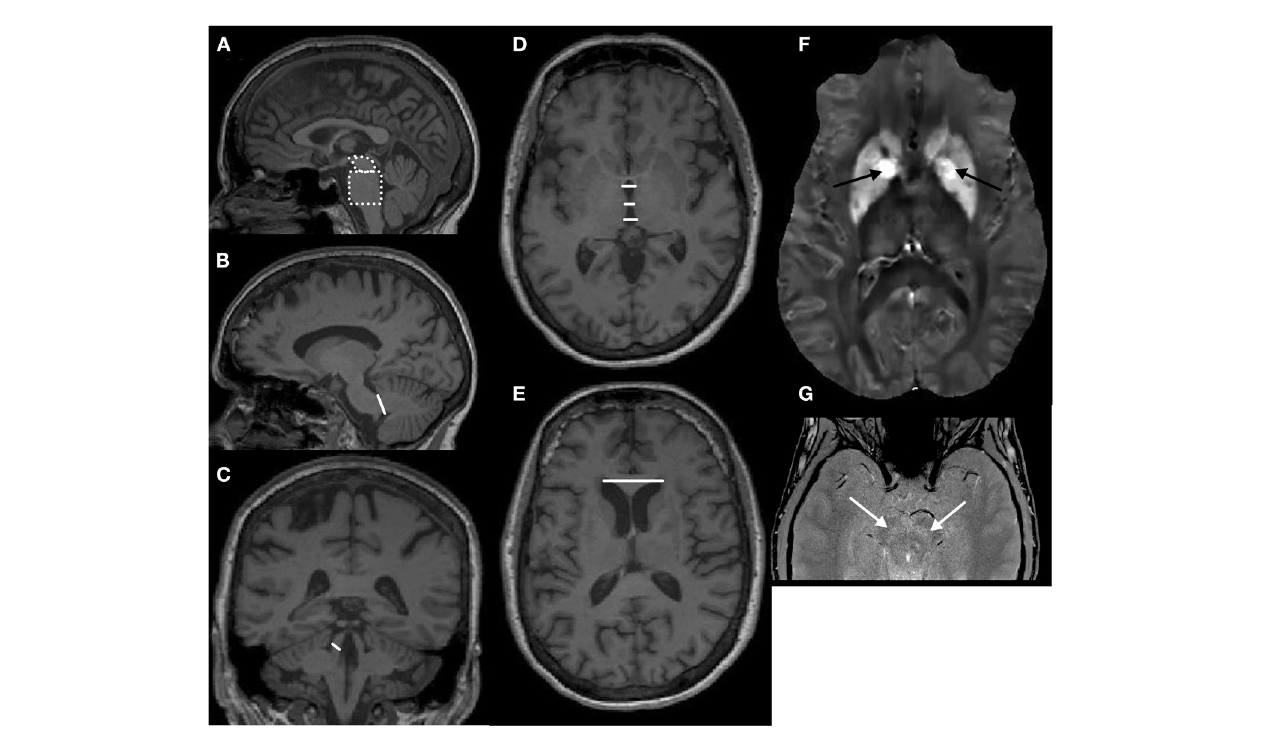
FIGURE1 (A–E) T1-weighted anatomical images demonstrating the landmarks for the calculation of the original magnetic resonance parkinsonism index (MRPI) and MRPI 2.0 (see the formulae in the main text). (A) The midbrain and pons areas outlined with white dotted lines on a sagittal image. (B) Middle cerebellar peduncle width marked with a white line on a sagittal image. (C) Superior cerebellar peduncle width marked with a white line on a coronal image. (D) Third ventricle width (anterior, middle, and posterior) marked with white lines on an axial image at the anterior commissure—posterior commissure level. (E) Maximum left-to-right frontal horn width marked with a white line on an axial image. (F) Quantitative susceptibility mapping: black arrows point to the iron depositions (bright areas) in the globus pallidus bilaterally on an axial image. (G) Neuromelanin scan using magnetization transfer gradient echo sequences: white arrows point to the bilateral neuromelanin-rich substantia nigra (hyperintense) on an axial